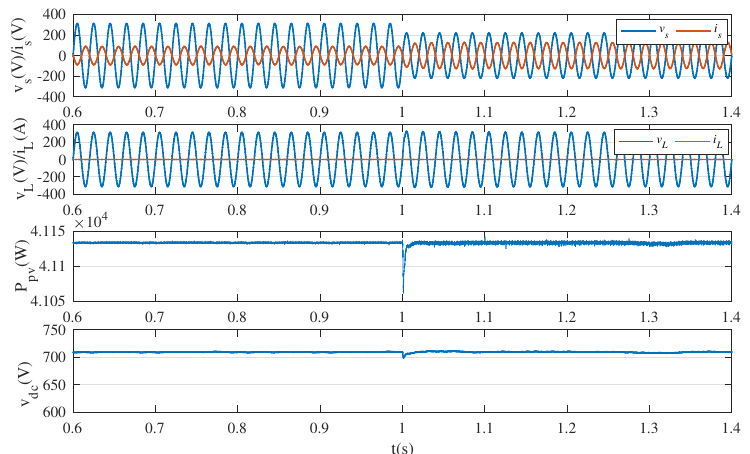
Figure 7. Simulation results under voltage sag with P L = 0.